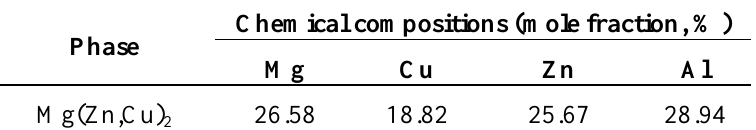
Figure 11. Bright-field TEM micrographs showing: ( a ) as-homogenized microstructure prior to deformation; and deformed microstructures at 350 °C and 0.001 s −1 with the true strain of ( b ) 0.1, and ( c ) 0.8. The electron beam is parallel to [011]